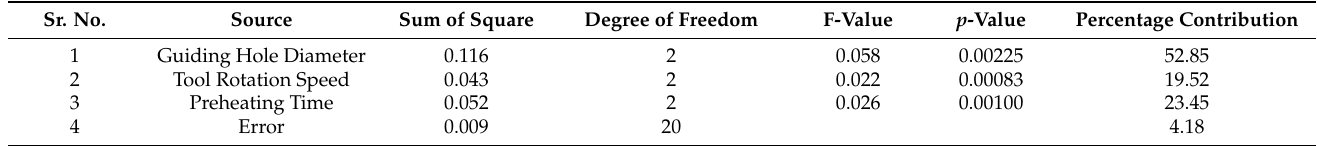
Table 8. ANOVA analysis of the final performance